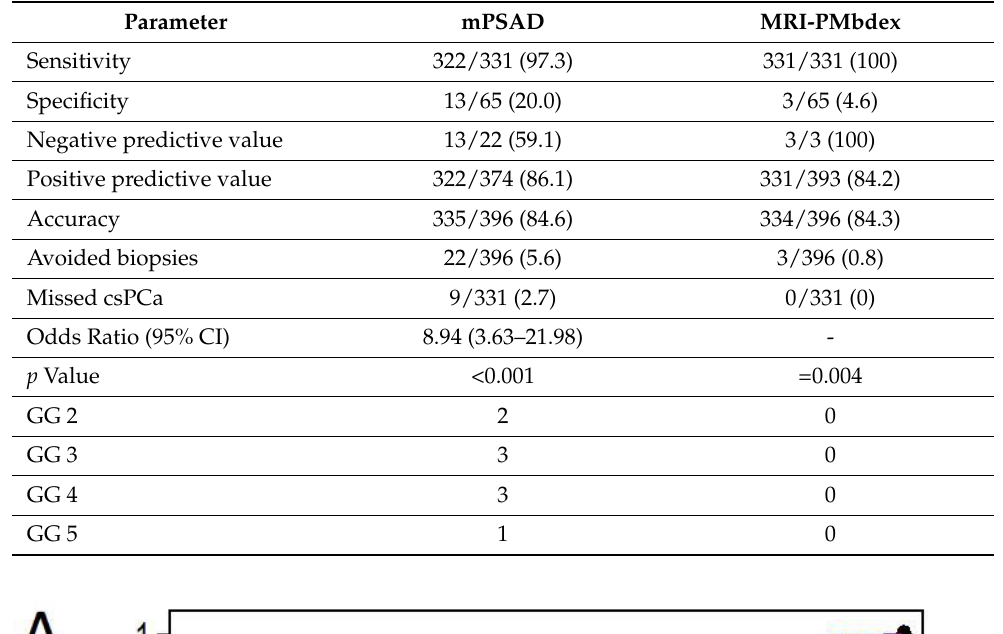
Table 7. Performance of MRI-PSAD and Barcelona MRI-predictive model in men with PI-RADS 5, from the respective thresholds of 0.628 ng/mL 2 and 13.5%.